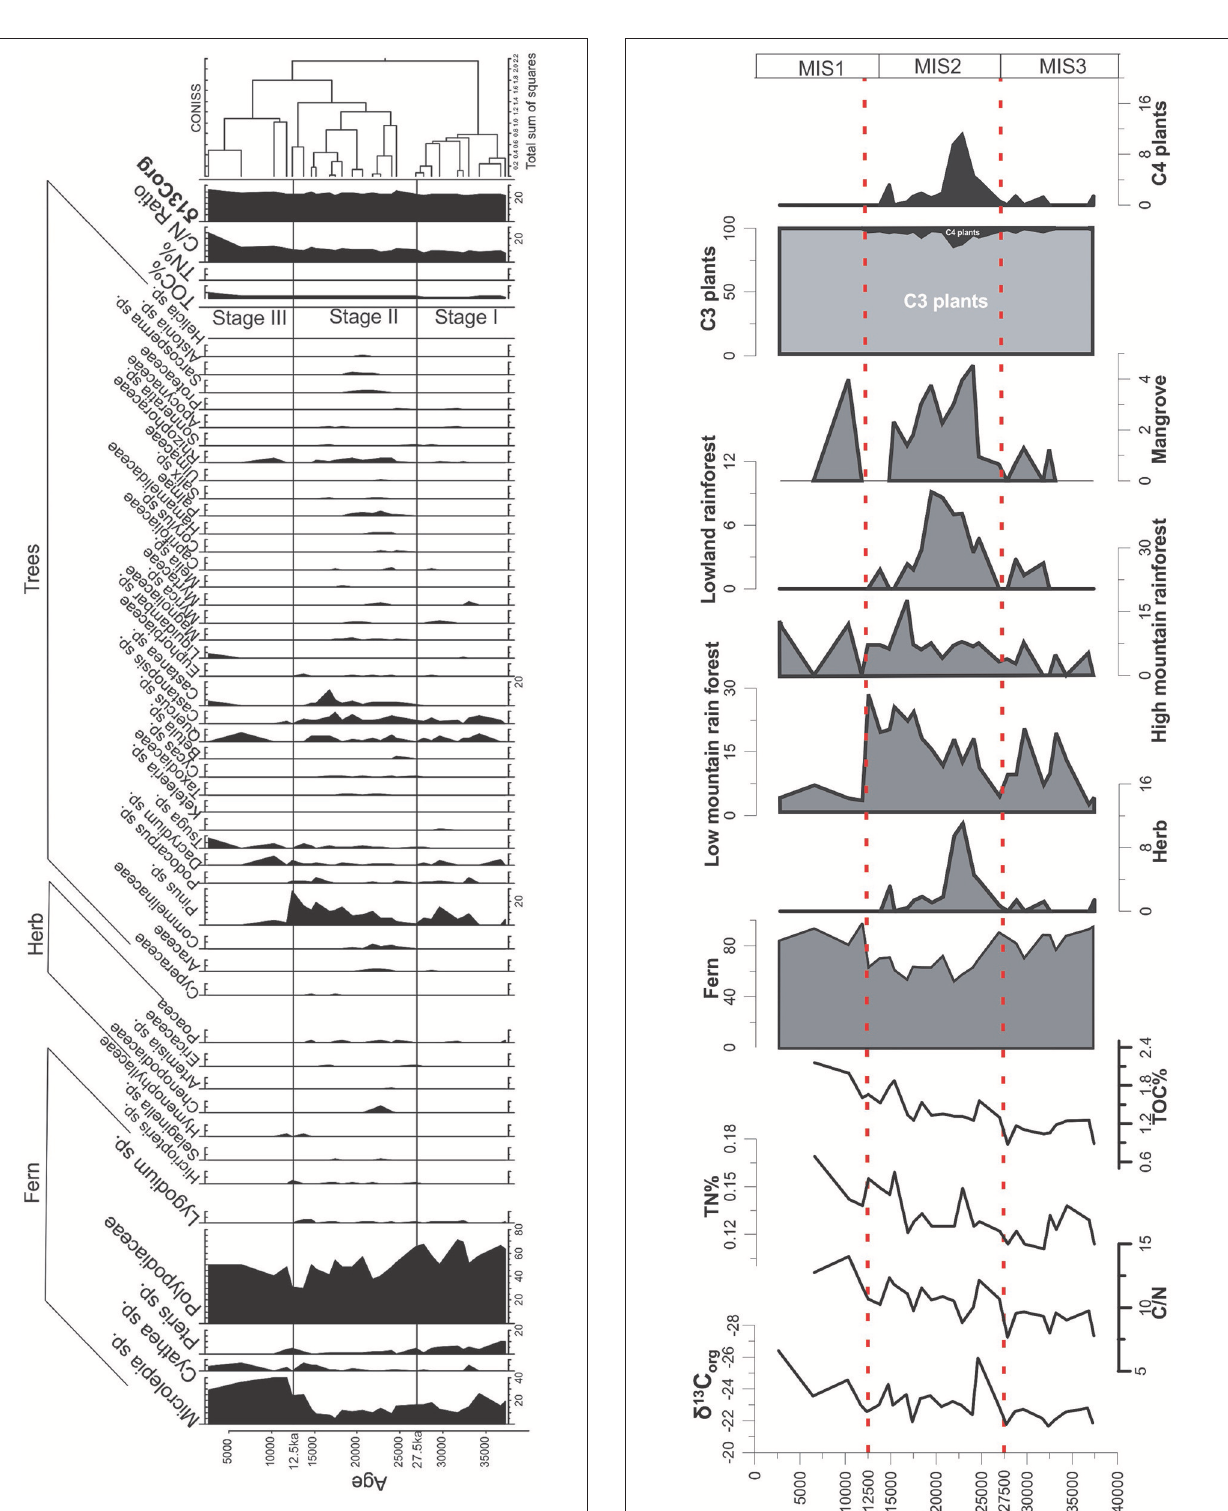
Frontiers in Earth Science | www.frontiersin.org